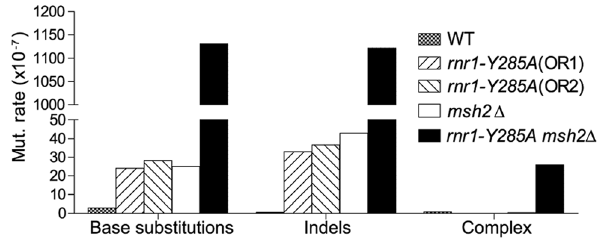
Figure 2. Mutations rates by class.